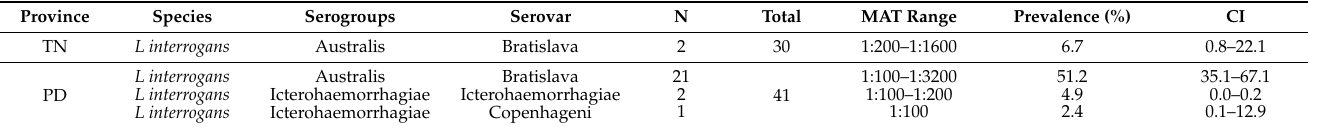
Table 1. Overall results of the serological survey conducted in coypus in the provinces of Trento and Padua, represented as the number of positive coypus (N), the total number of enrolled coypus (Total), the MAT titre ranges of positive samples, the observed prevalence and the confidence interval of 95% (CI).